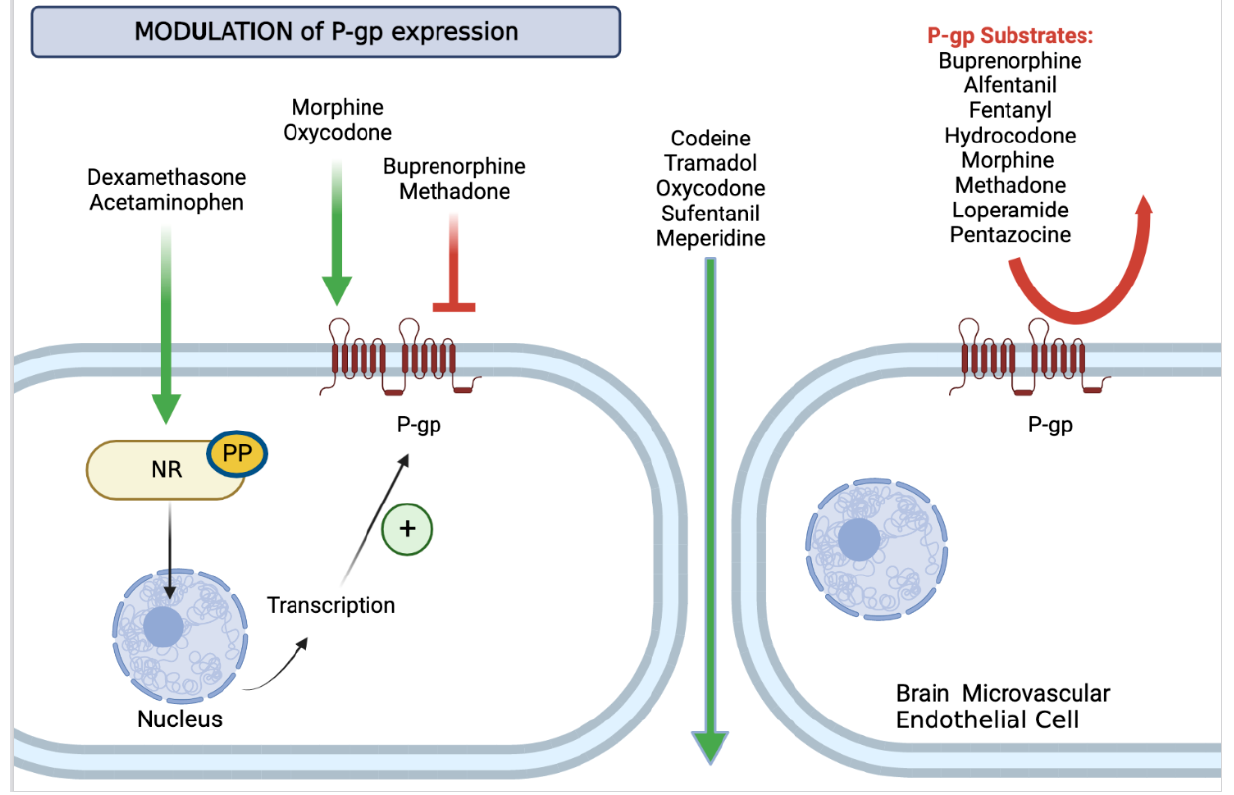
Figure 1. Modulation of P-gp expression at the BBB by analgesics. P-gp limits opioid distribution in the brain. ( Right Side ) Most opioids are known to be P-gp substrates (red arrow), therefore, increased expression of P-gp potentiates their efflux and prevents their delivery in the central nervous system. Other opioids are not P-gp substrates (green arrow) and this could explain the faster onset of action. ( Left Side ) Chronic opioid exposure may also modulate P-gp activity: morphine and oxycodone are P-gp inducers (green arrow), while buprenorphine and methadone are inhibitors (red inhibition arc) of ATP-Binding Cassette (ABC) trasporters at the blood-brain barrier (BBB). Other drugs commonly used in pain management may modulate P-gp expression at the BBB, through intracellular mechanisms of nuclear transcription. Dexamethasone and paracetamol bind the nuclear receptor (NR), which, after dephosphorylation by a protein phosphatase (PP), translocates to the nucleus and binds its response element on a target gene, leading to protein transcription and overexpression of ABC transporters, such as P-glycoprotein (P-gp) on the membrane of brain microvascular endothelial